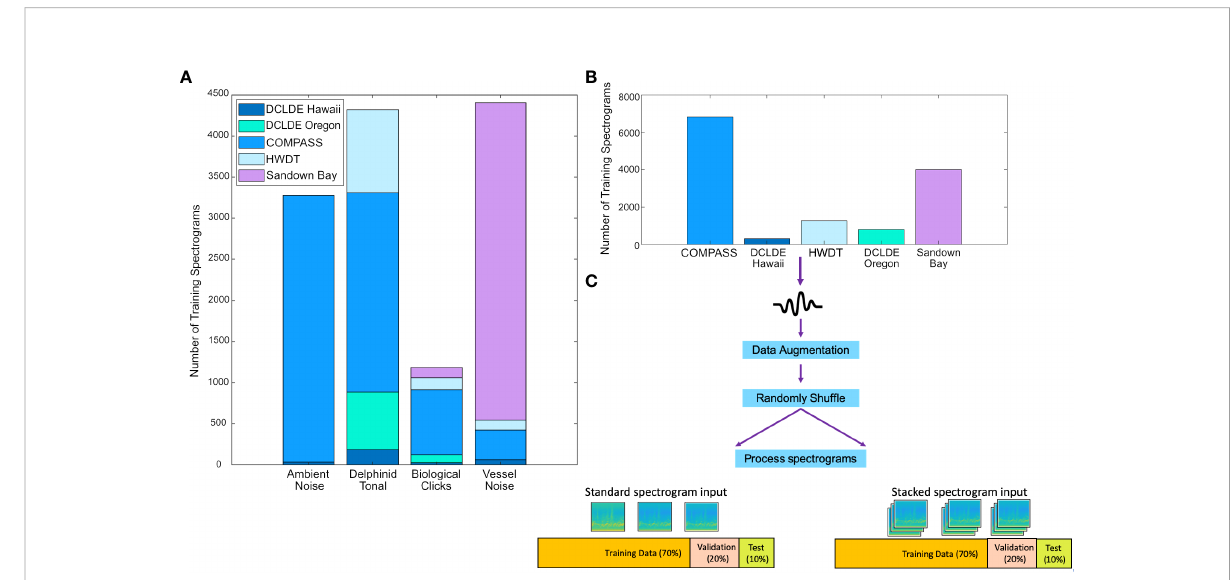
FIGURE 2 Creation of the training, validation and test sets. Sound fi les came from a range of data sources with differing recording hardware, survey platforms and location (see main text for more information). (A, B) Raw audio was manually collated into three-second frames each containing an example of ambient noise, delphinid call types or vessel noise. (C) To train and evaluate the model the sound sources, post augmentation, were randomly shuf fl ed and divided into three folders; Training – 70%, Validation – 20% and Testing – 10%. Two datasets were computed for the standard spectrogram input and the stacked spectrogram input. The validation set was used to evaluate model performance during each iteration of training. The test set was shown to the model after training to test its performance on unseen data.